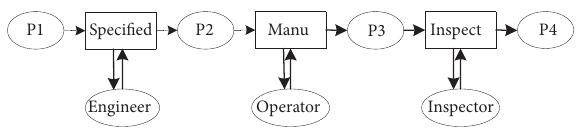
Figure 7: Subprocesses CPN of